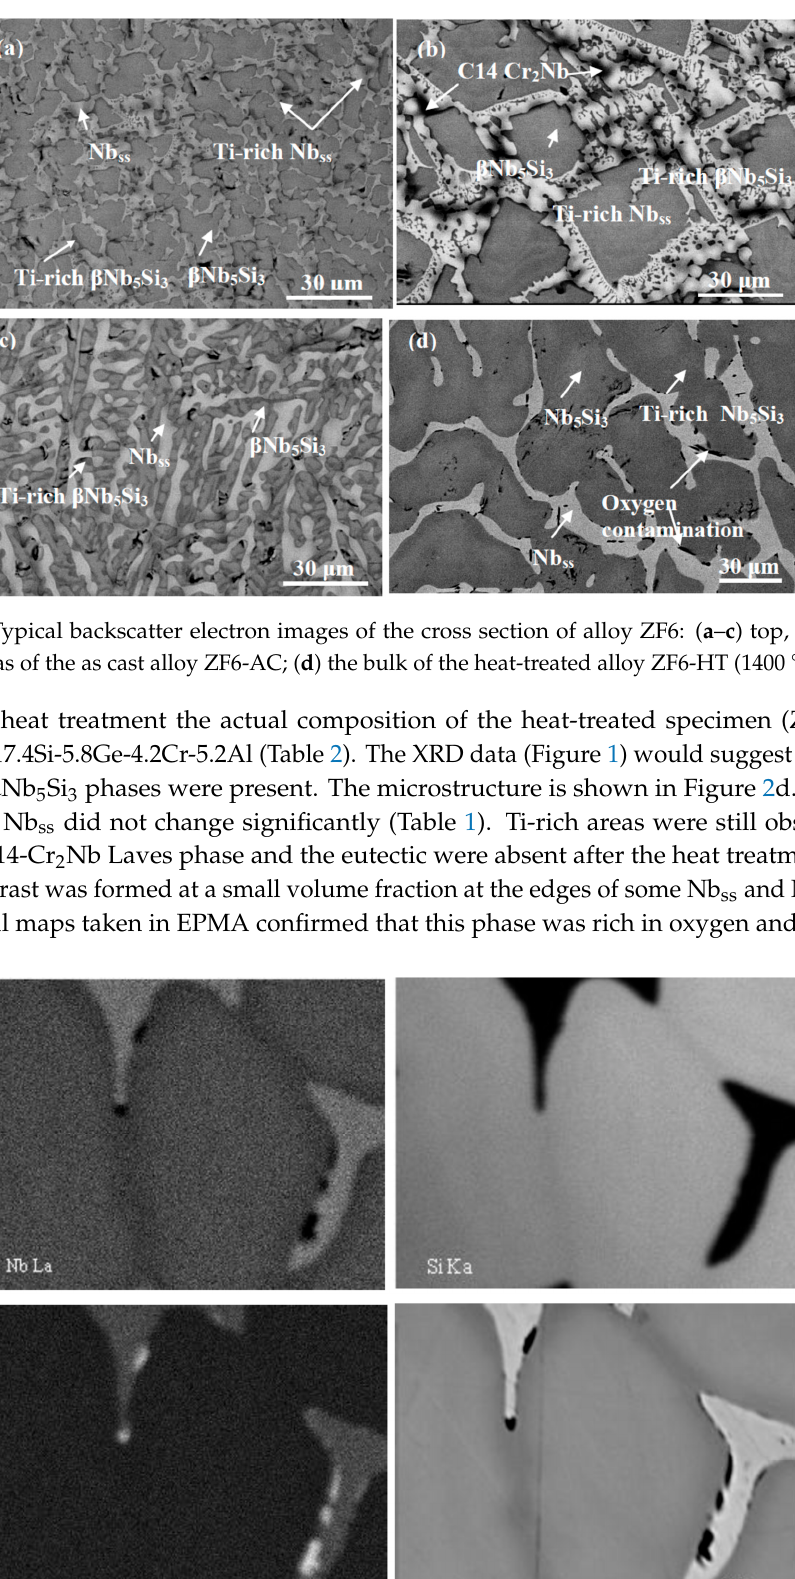
Figure 1. X-ray diffractograms of the as cast and heat treated (1400 °C/100 h) alloy ZF6.